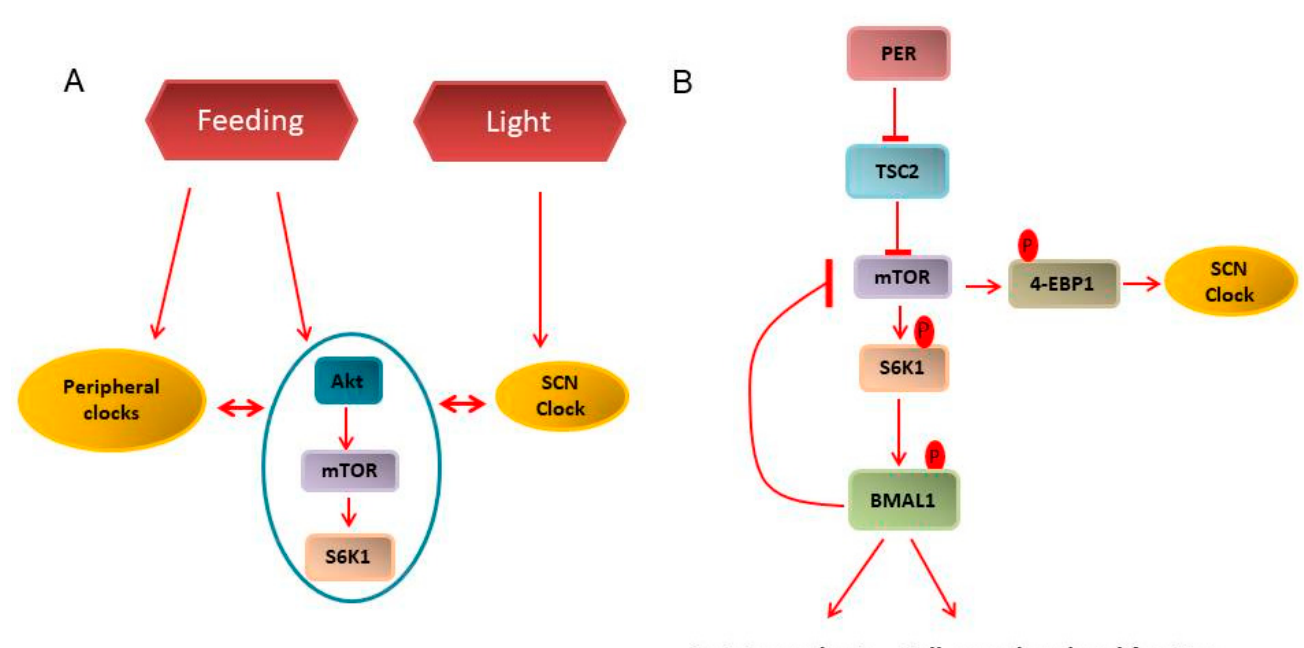
Figure 3. Clock and mTOR pathway interconnection. ( A ) Environmental cues such as light synchronizes the master clock in suprachiasmatic nucleus (SCN) while feeding regimen entrains the peripheral and metabolic clock. Further, peripheral and SCN clocks directly cross-talk with the metabolic clock, i.e., PI3K/Akt/mTOR. ( B ) mTORC1, through 4-EBP1 phosphorylation, regulates the SCN clock. In the periphery, a feedback loop is formed in which mTORC1 regulates BMAL1 activity through S6K1 mediated phosphorylation, while BMAL1 accumulation, in turn, inhibits mTOR activity. Constitutive mTORC1 activation for example, by Tsc2 inhibition, disturbs this feedback loop that could, in turn, drive uncontrolled protein synthesis, cellular growth and proliferation, thus, contributing to cancer development.